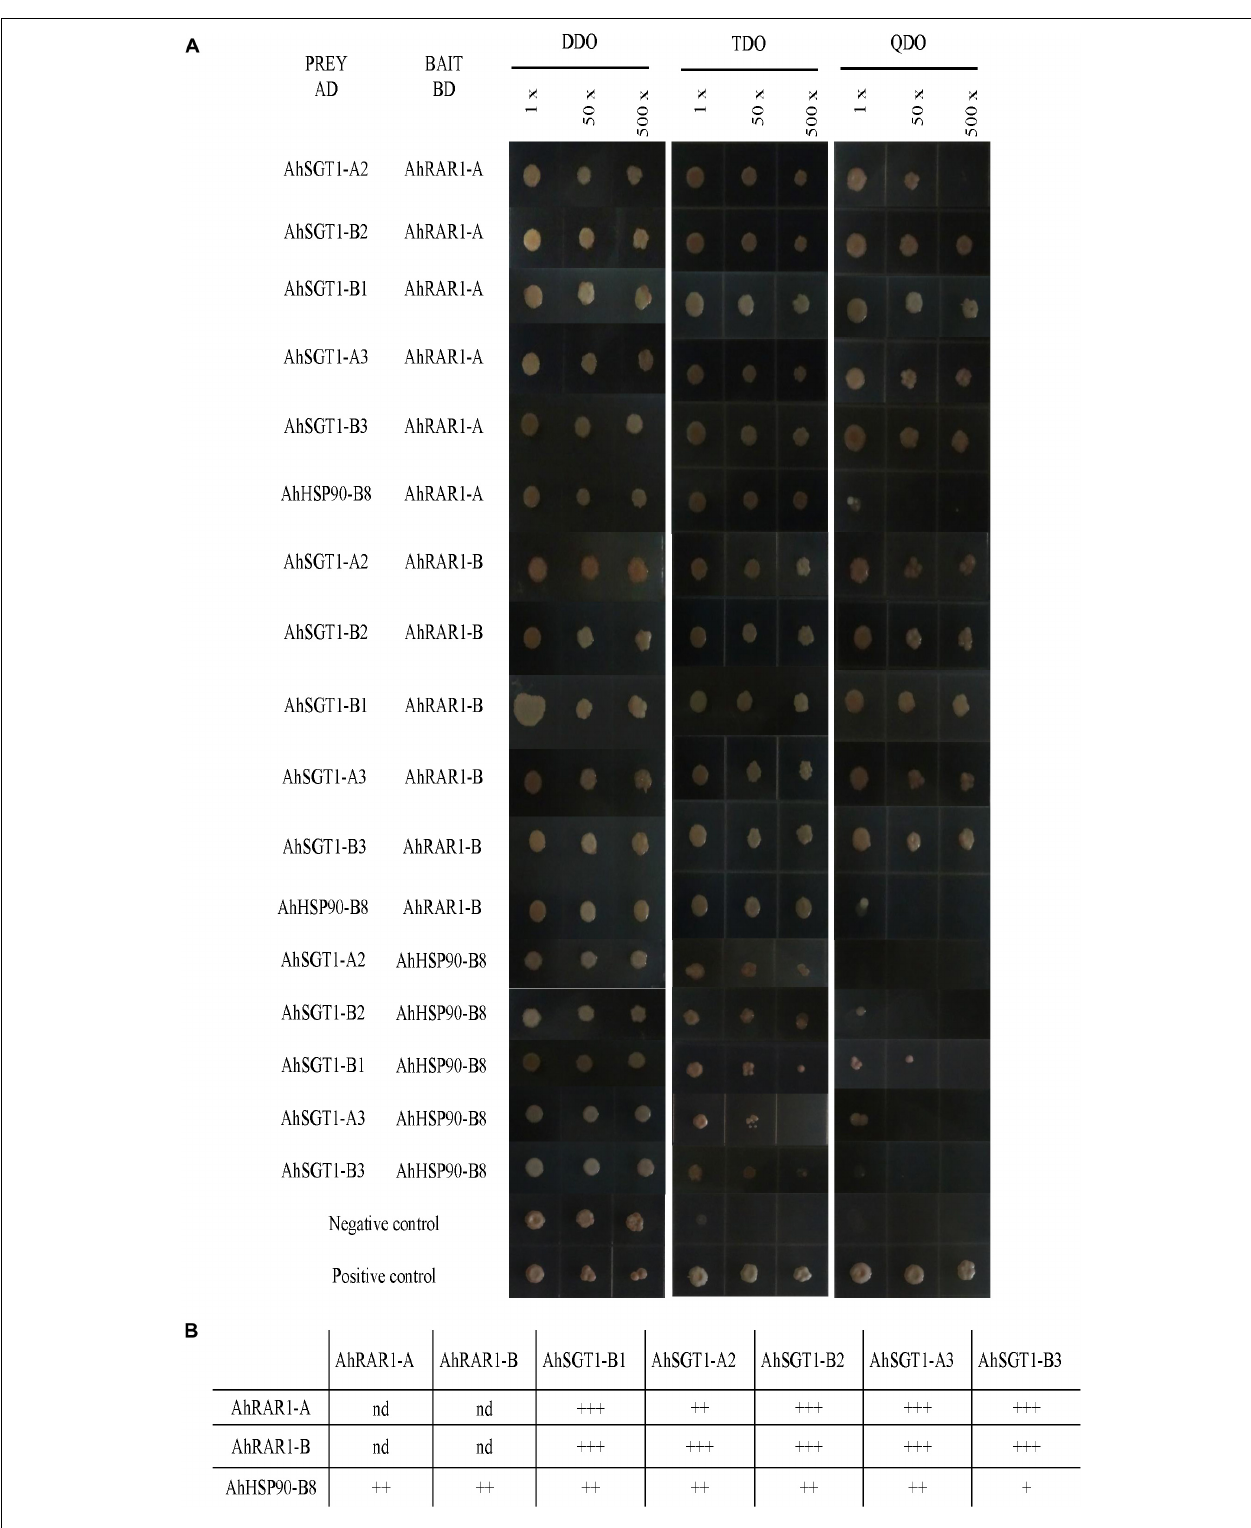
Frontiers in Genetics |